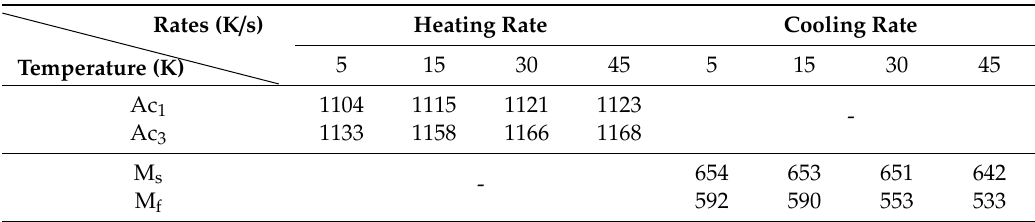
Figure 1. Schematic diagram showing the joint geometries of two butt welds: ( a ) T91 tube and ( b ) Gr. 91 plate and the creep samples cut from the completed welds. Table 2. The transformation temperatures of Gr. 91 weld metal (WM) determined by a dilatometer at specific heating / cooling